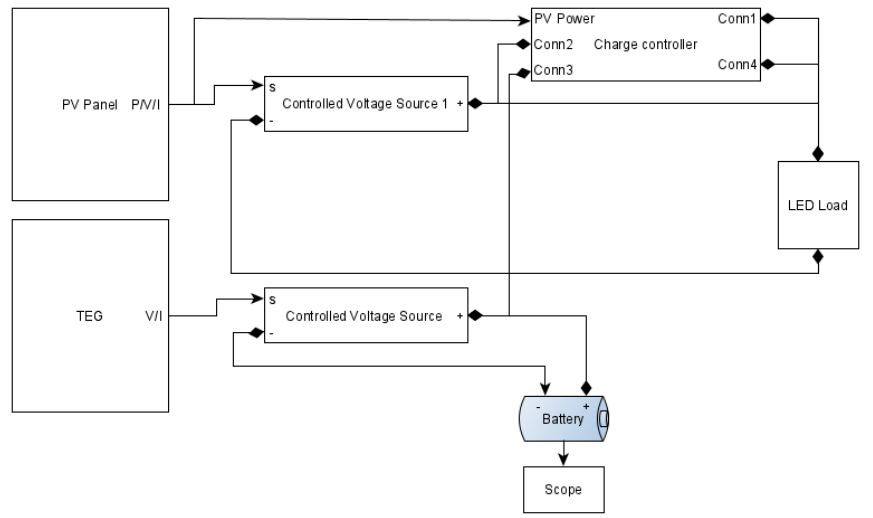
Figure 9. Hybrid system (HS) with battery bank model [36].